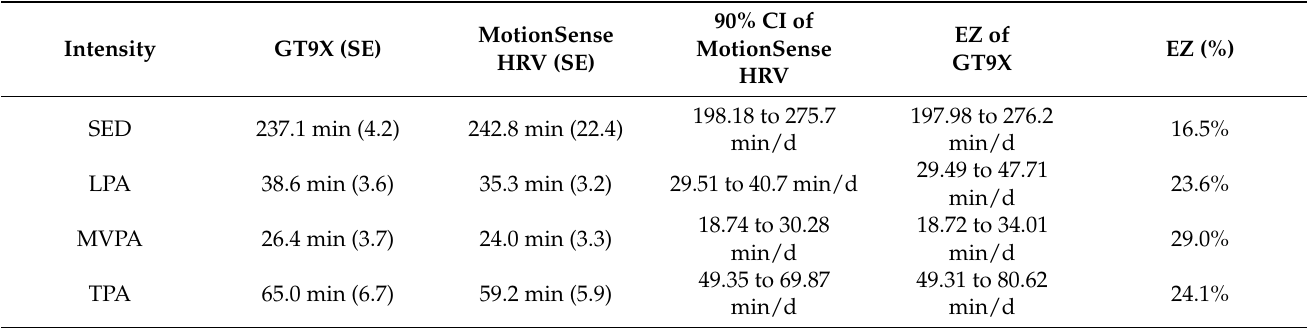
Table 5. 90% Confidence Intervals (CIs) from the MotionSense HRV and Equivalence Zones (EZs) from the GT9X in free-living conditions.